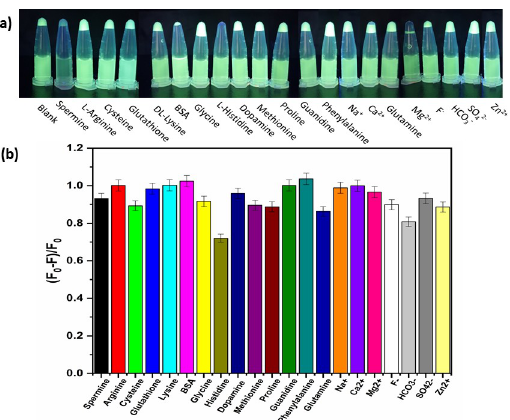
Fig 7. (a) Images of the samples under an explosion of UV lamp exhibited that FL of CP-Tb 3+ complex was strongly quenched by SP (0.1 mM) as compared with available interferences (1 mM); (b) Effect of available interferences on (F 0 –F)/F 0 ratios of CP-Tb 3+ in the simultaneous presence of SP (0.1 mM) and another compound (1 mM) (F 0 , F are FL intensity of CP-Tb 3+ complex in the absence and existence of analytes,